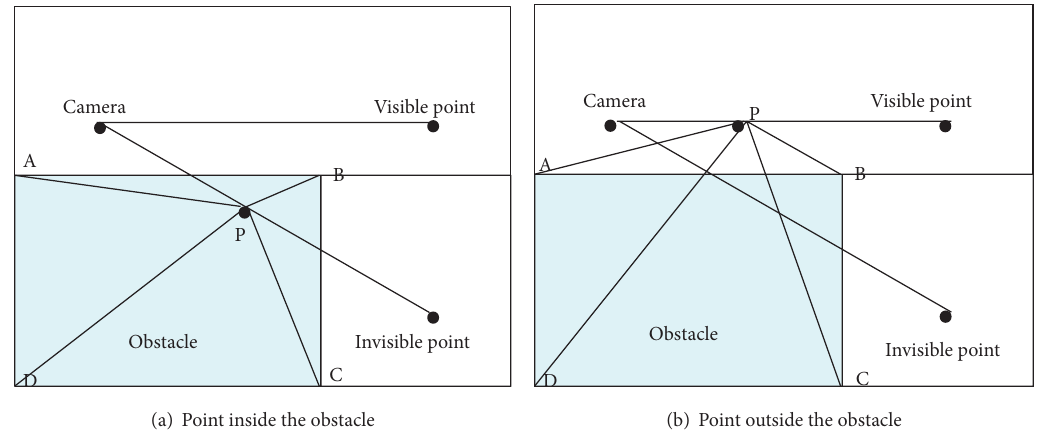
Figure 4: The impact of obstacle: if the line segment crosses the obstacle, then the point cannot be monitored.